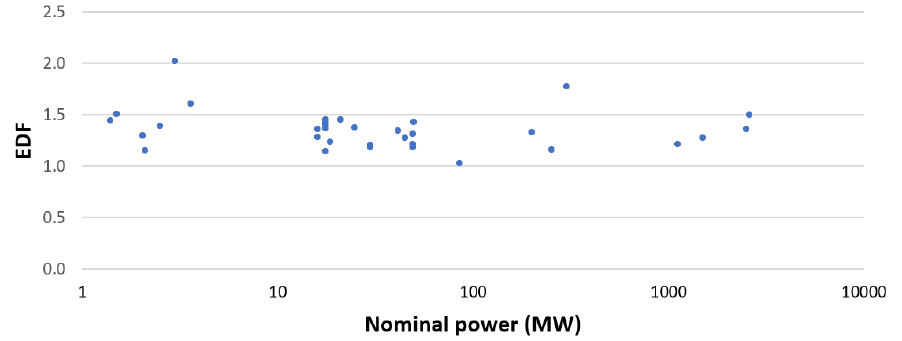
Figure 20. Magnitude of EDF depending on rated power of the system.